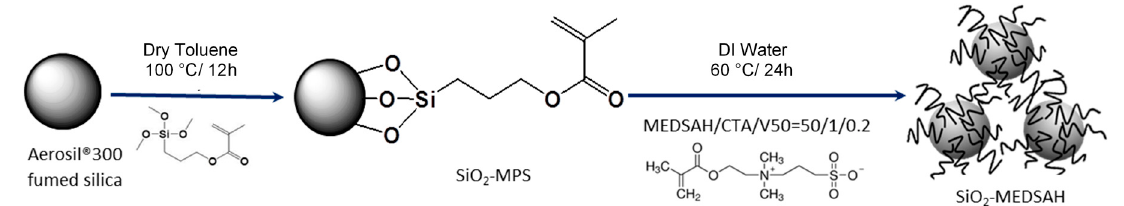
Figure 3. Schematic of preparation polymer modified nanoparticles.